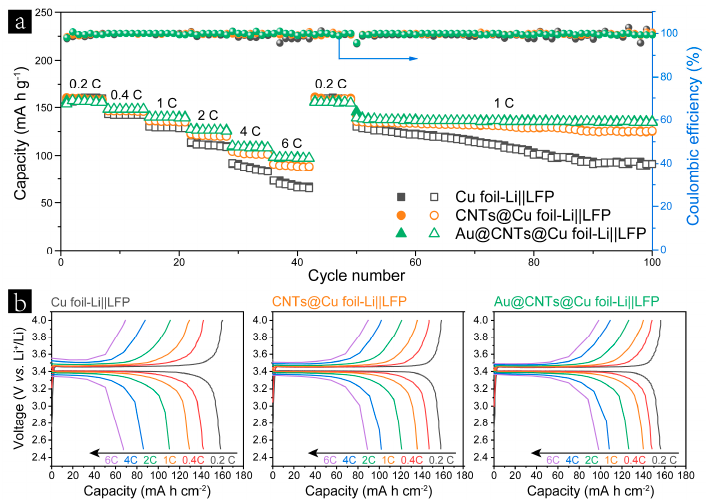
Figure 5. ( a ) Rate capabilities and cycling performances of the predeposited Cu foil-Li, CNTs@Cu foil-Li, and Au@CNTs@Cu foil-Li anodes in full-cell configuration at various rates from 0.2 to 6 C. ( b ) Charge/discharge curves of the full cells with the configuration of Cu foil-Li||LFP, CNTs@Cu foil-Li||LFP, and Au@CNTs@Cu foil-Li||LFP at different current rates from 0.2 to 6 C.